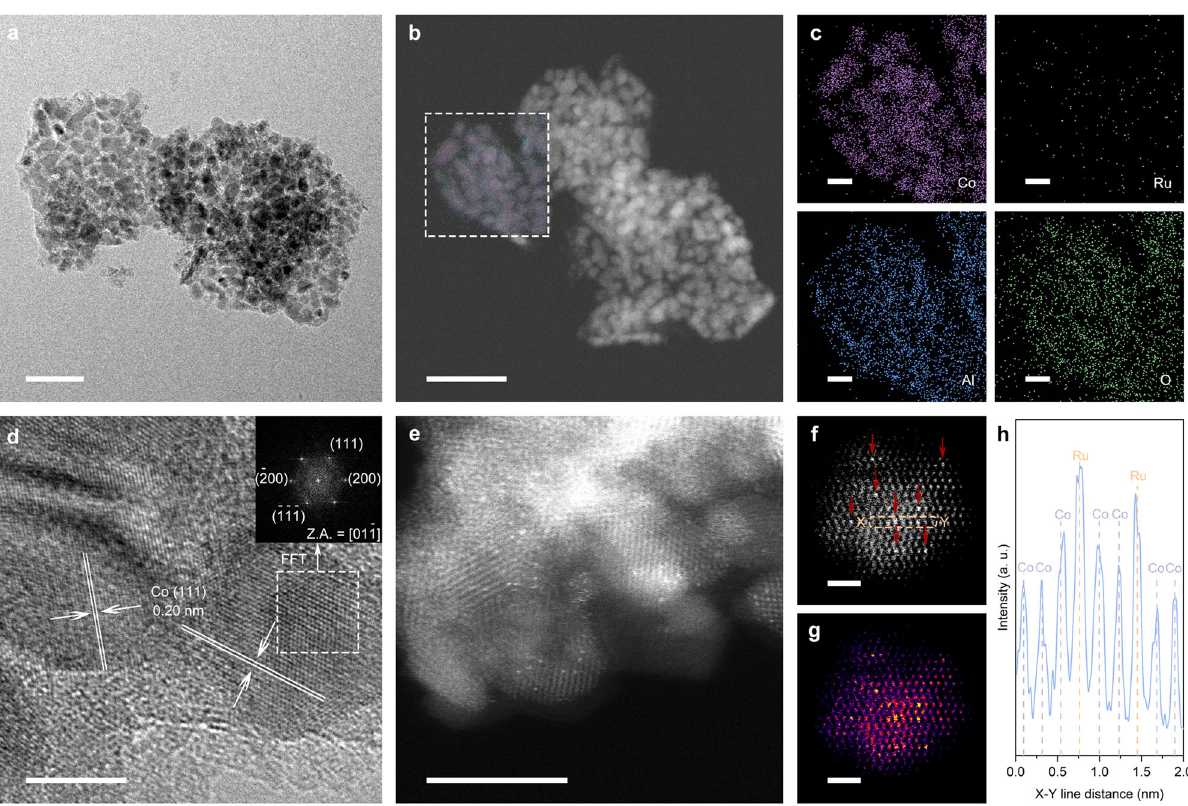
Fig. 2 | Morphology of the Ru 1 Co-SAA catalyst. a HRTEM image of Ru 1 Co-SAA at low magni fi cation. Scale bar, 50nm. b HAADF-STEM image of the Ru 1 Co-SAA cat- alyst. Scale bar, 50nm. c EDS element maps for Co, Ru, Al and O in the dotted-box area. Scale bar, 10nm. d HRTEM image of Ru 1 Co-SAA at high magni fi cation.